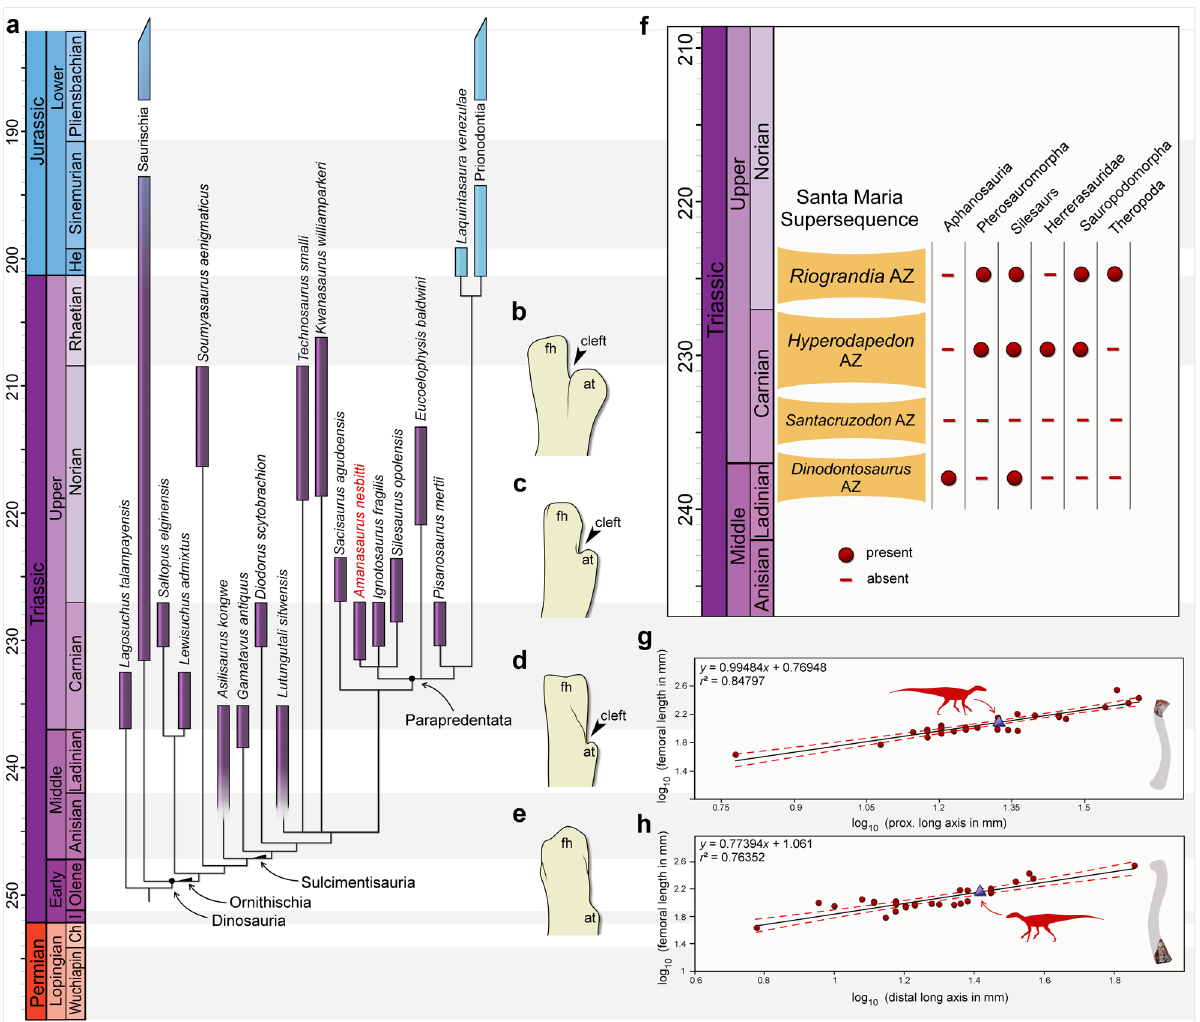
Figure 3. Results of the analyzes. ( a ) Time-calibrated reduced strict consensus tree depicting the phylogenetic position of Amanasaurus nesbitti gen. et sp. nov. ( b ) Left (reversed) femur of Scutellosaurus lawleri (MNA 175) in lateral view. ( c ) Left (reversed) femur of Eucoelophysis baldwini (NMMNH P-22298) in lateral view. ( d ) Right femur of Amanasaurus nesbitti gen. et sp. nov. (CAPPA/UFSM 0374) in lateral view. ( e ) Right femur of Lewisuchus admixtus (CRILAR-Pv 552) in lateral view. ( f ) Occurrence of Pan-Aves according the Middle to Upper Triassic Assemblage Zones of Brazil; ( g ) Plot of log 10 -transformed proximal long axis of the femur versus log 10 -transformed femoral length of distinct ornithodirans depicting (purple triangle) the estimated femoral length for the holotype of Amanasaurus nesbitti gen. et sp. nov. ( h ) Plot of log 10 -transformed distal long axis of the femur versus log 10 -transformed femoral length of distinct ornithodirans depicting (purple triangle) the estimated femoral length for the referred specimen of Amanasaurus nesbitti gen. et sp. nov. Figures were generated with GIMP 2.8 (https:// www. gimp.